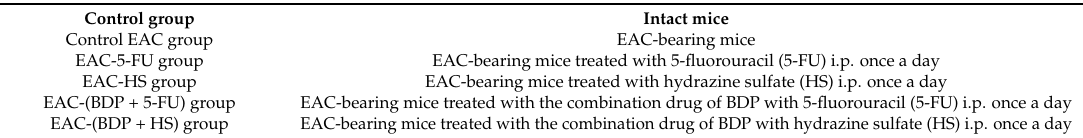
Table 2. The characteristic of animal experimental